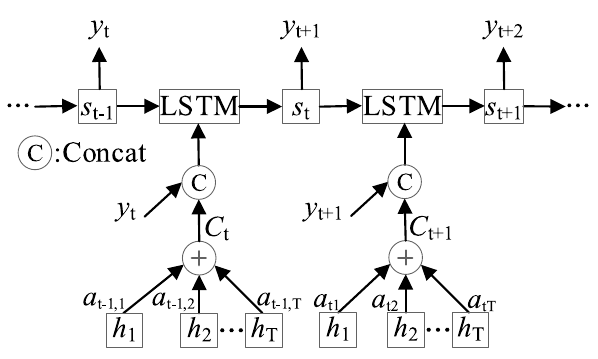
Algorithm 1 Implementation of feature coding